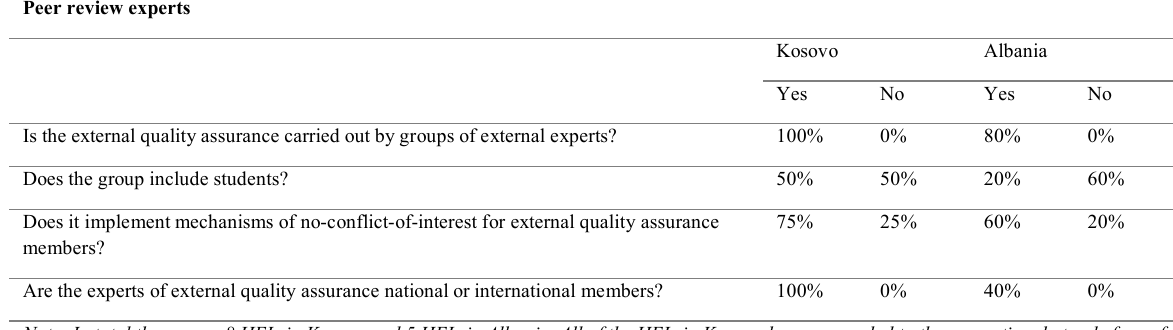
Table 9: External quality assuranc: Peer review experts (HEIs in Albania and Kosovo) Peer review